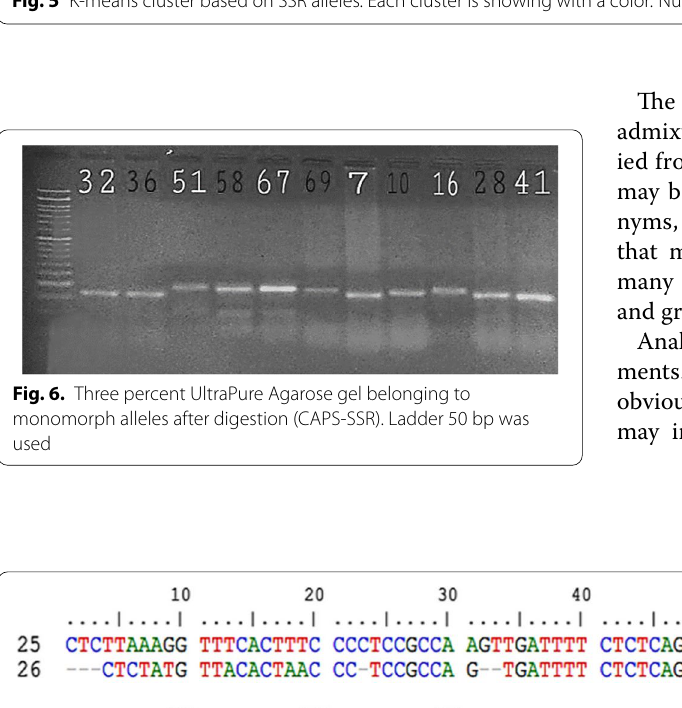
Fig. 5 K-means cluster based on SSR alleles. Each cluster is showing with a color . Number of individuals are according to Table 1